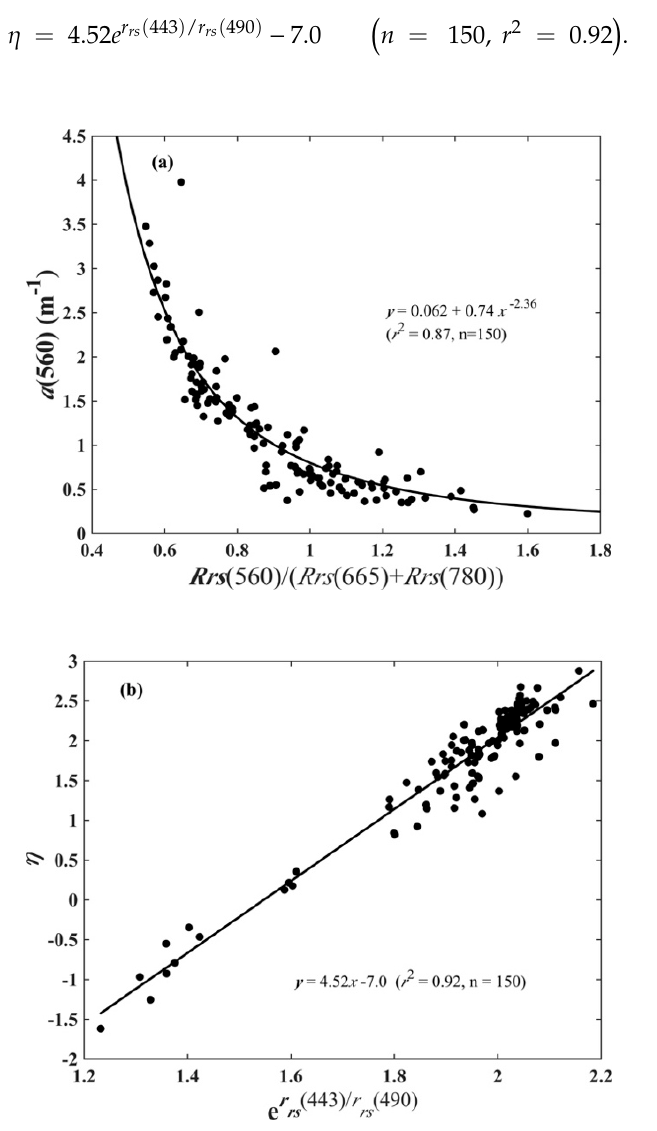
Figure 5. Empirical models for a (560) ( a ) and η ( b ).